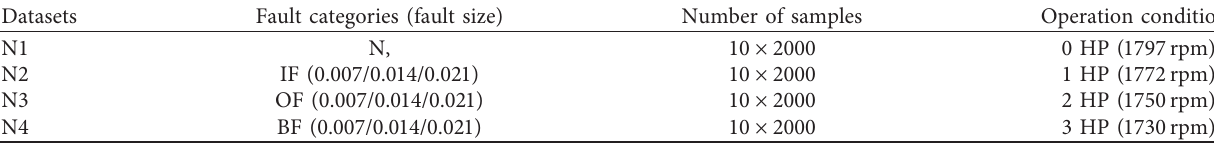
Table 1: Introduction to